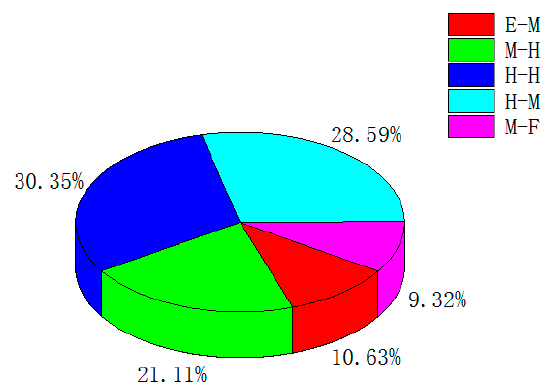
Figure 1. Energy dissipation of each energy conversion unit during a working cycle. (E-M, electrical–mechanical energy unit; M-H, mechanical–hydraulic energy unit; H-H, hydraulic–hydraulic energy unit; H-M, hydraulic–mechanical energy unit; M-F, mechanical-forming energy unit). During the past decades, researchers are applying an increasing amount of effort to achieve the match between the installed power and the required power for hydraulic presses. As reported by Zhao [6] and Huang [7], energy-matching methods for hydraulic presses can be divided into two categories: energy-matching methods and energy-recovery methods.